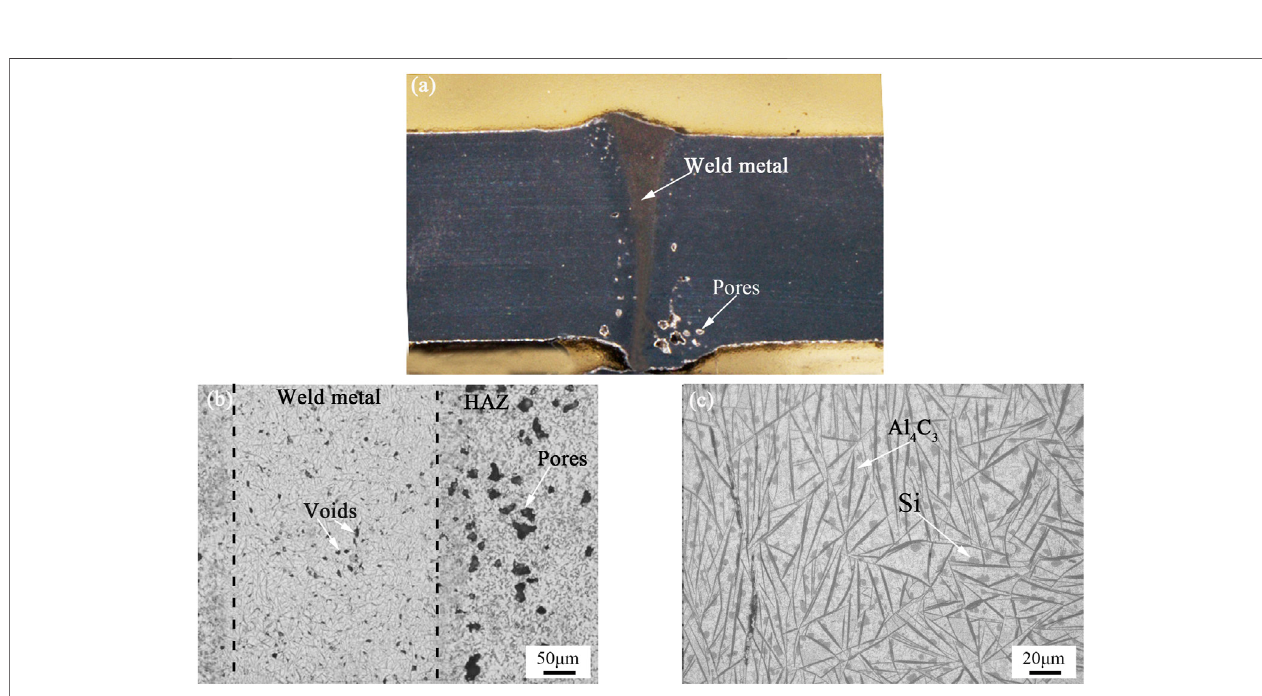
FIGURE5 | Cross-section and optical micrographs ofSiCp/6061Al laserwelded joint: (A) transversecross section ofthe joint (B) microstructureof weld metal (C) enlarged view of weld metal.